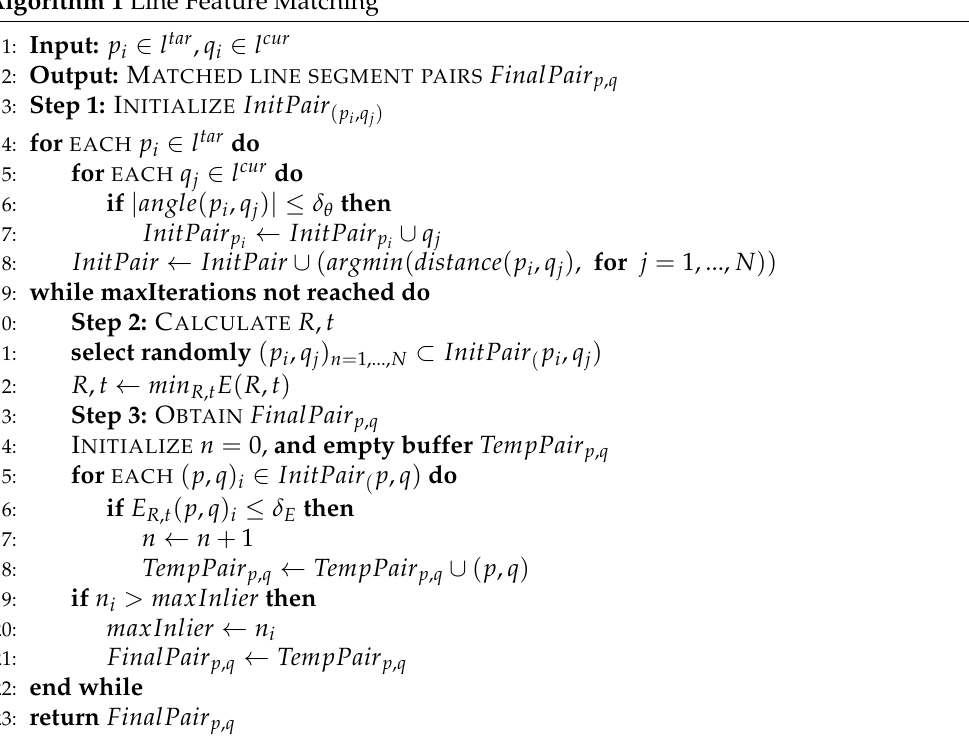
Algorithm 1 Line Feature